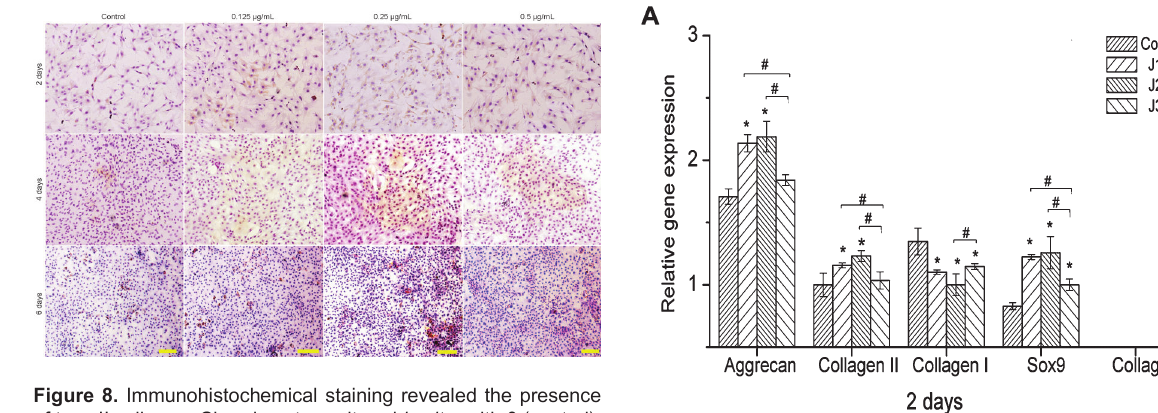
Figure 8. Immunohistochemical staining revealed the presence of type II collagen. Chondrocytes cultured in vitro with 0 (control), 0.125, 0.25, and 0.5 m g/mL JJYMD-C for 2, 4, and 6 days. Scale bar: 100 m m.